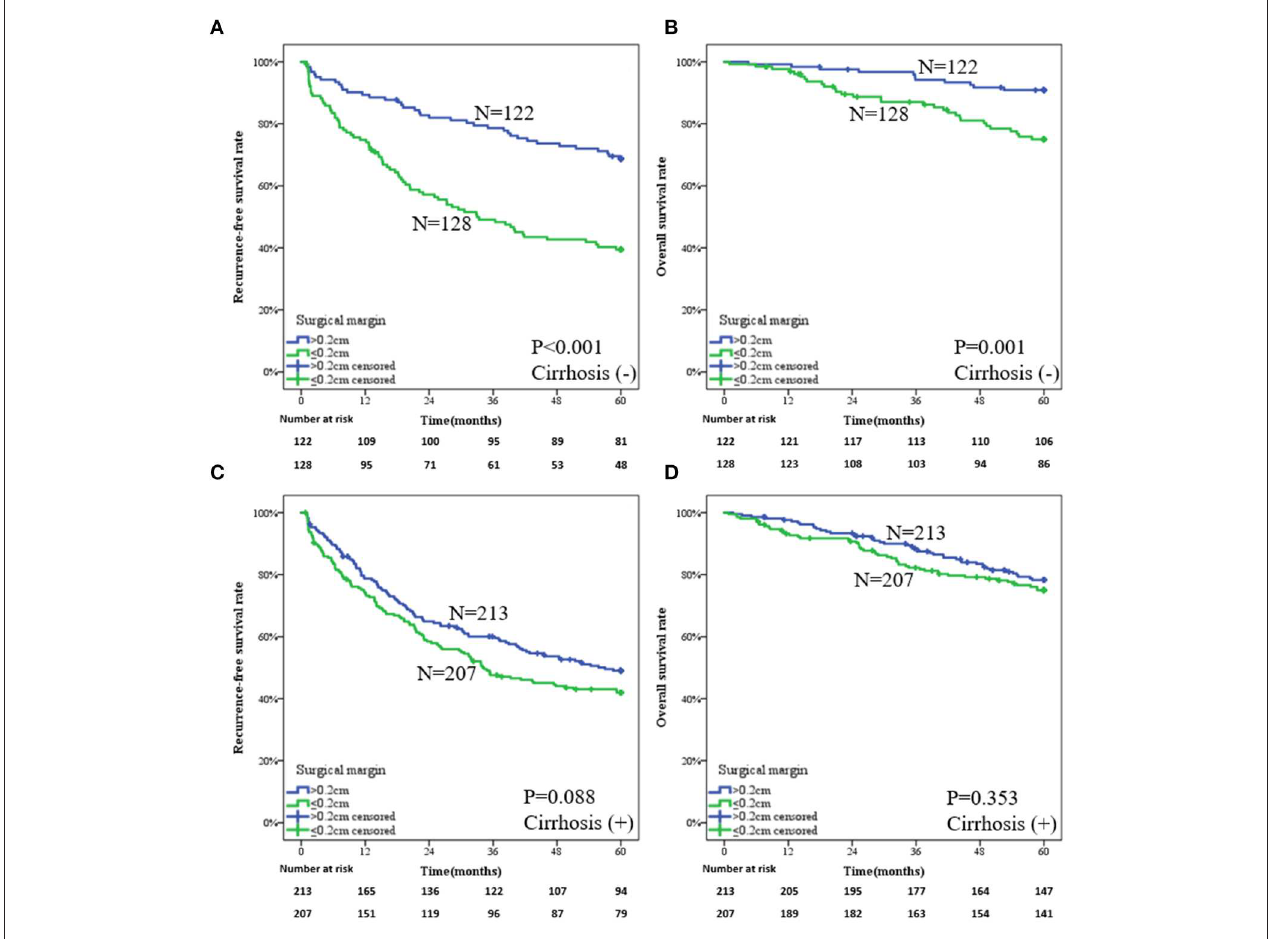
FIGURE 4 | Subgroup analysis of a wide-margin vs. a narrow-margin liver resection for the patients in the propensity score matching group. (A) Recurrence-free survival in the patients without liver cirrhosis, (B) overall survival in the patients without liver cirrhosis, (C) recurrence-free survival in the patients with liver cirrhosis, (D) overall survival in the patients with liver